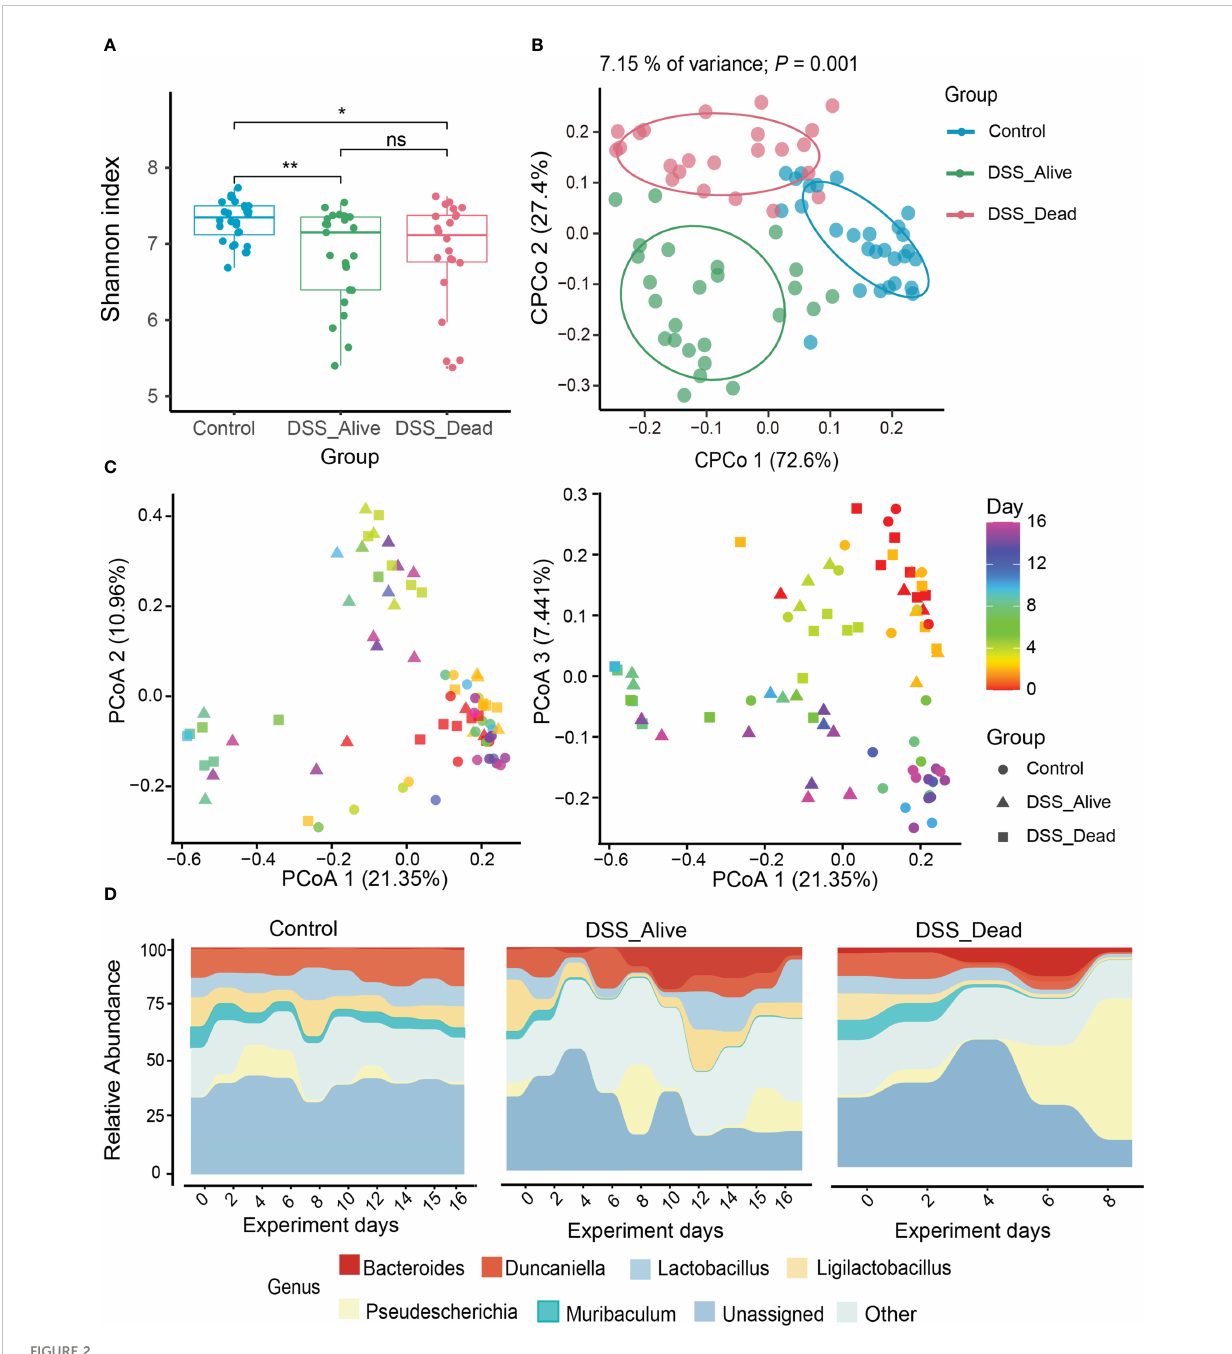
FIGURE 2 Diversity and composition dynamics of the three group. (A) The comparison of Shannon index among three groups. (B) The analysis of CPCoA between three groups. (C) Beta diversity of three groups analyzed by PCoA. Color bars represent experimental days, and different groups are represented by different symbols. (D) Bacterial community composition at the genus level among Control group, DSS_Alive group and DSS_Dead group. Wilcoxon rank-sum test was used to test signi fi cance in boxplot. n.s. means no signi fi cance, * means P < 0.05, ** means P <